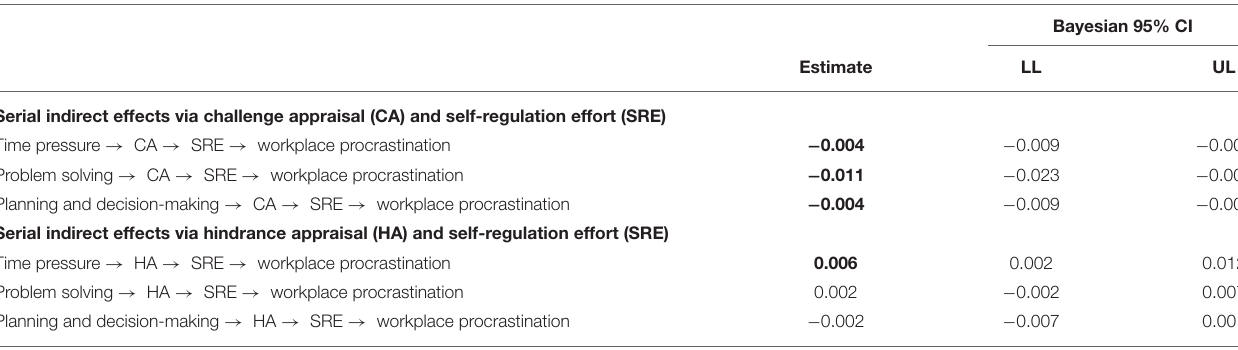
TABLE 3 | Within-person serial indirect effects from Bayesian MSEM with credibility